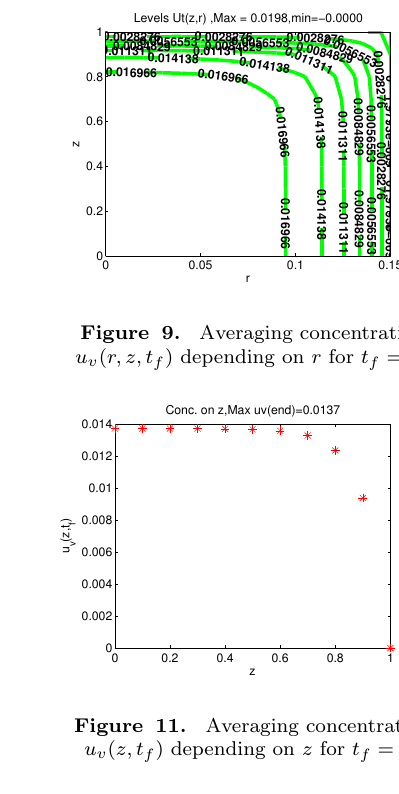
The maximal values of u v ( r, t f ) , u v (0 , t ) , u ( r, z, t f ) , u vv ( t ), a vv ( t ) , u vv ( t f ) for different ˜ p are presented in Table 1.